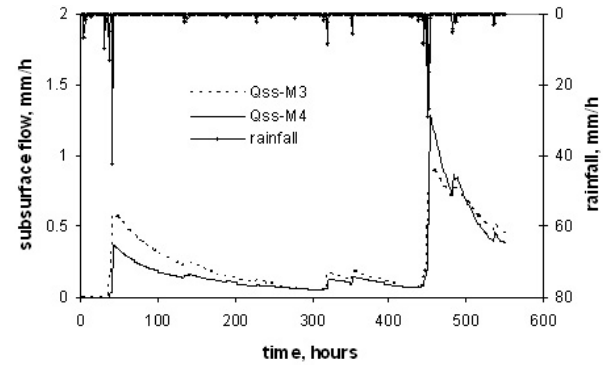
Fig. 4. Comparison between runoff responses generated by Models 3 and 4 (M3 and M4) using S b =300mm and η